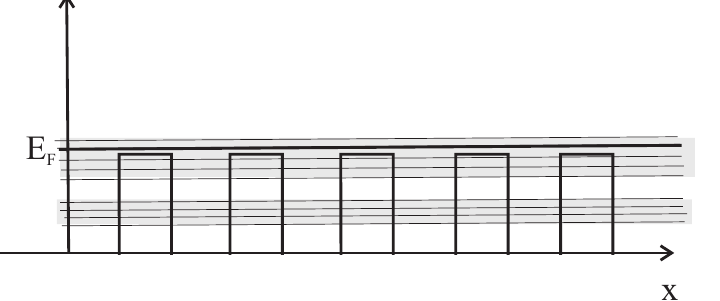
Figure 2. Schematic representation of a solution with five barriers. The allowed bands determined by Bloch theorem are marked in gray, inside which are indicated the discrete energy levels with perfect transmission R =